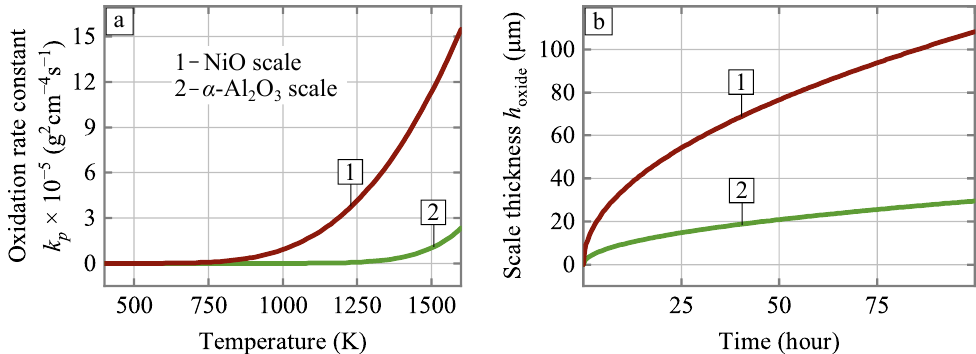
Figure 6. ( a ) Oxidation rate constants dependency on the temperature and ( b ) the scale thickness evolution for two (NiO, Al 2 O 3 ) cases of oxide formation under 1300 K.